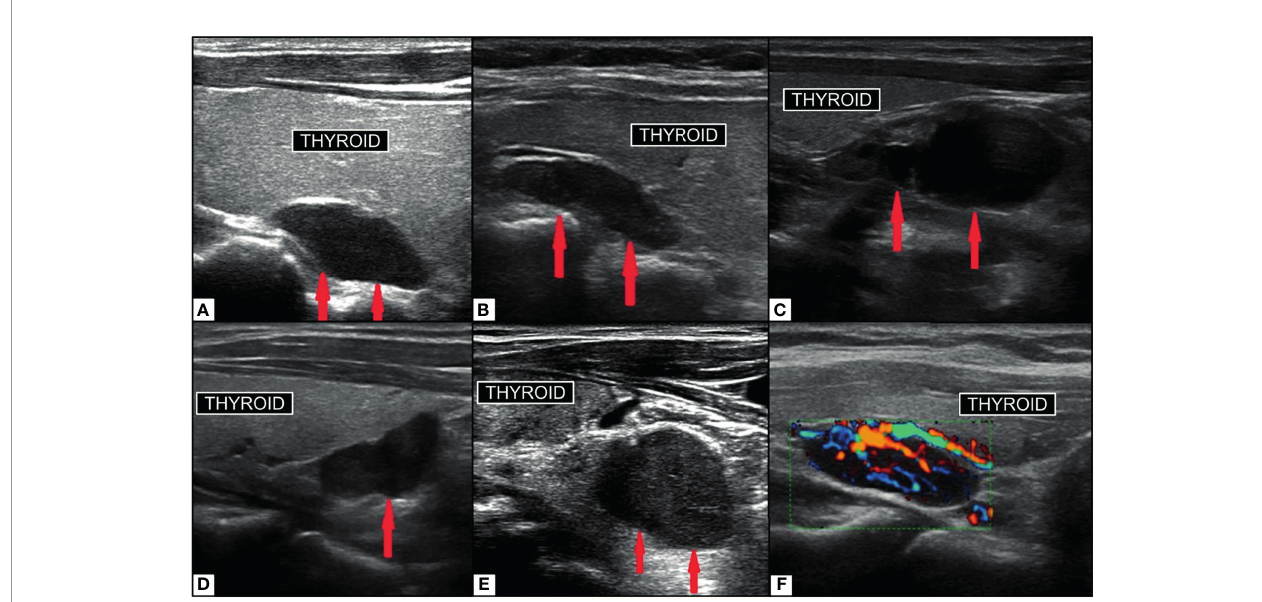
FIGURE 7 | Ultrasound imaging of parathyroid adenoma (red arrows). Right superior PA (A) in median retrothyroidal location, hypoechoic, measuring 2.2cm. Left superior PA (B) in the upper retrothyroidal location, hypoechoic, measuring 2.3 cm. Predominantly cystic right inferior parathyroid adenoma (C) adjacent to lower pole of thyroid, anechoic, measuring 3.5 cm. Right inferior PA (D) in the lower retrothyroidal location, hypoechoic, measuring 2 cm. Left inferior PA (E) near the lower pole of thyroid extending to the retrosternal region, hypoechoic, measuring 2.3 cm. PA on color-doppler ultrasonography (F) with central hyperemia and afferent ‘ polar ’ vessel. Reproduced with permission from: Vitetta GM, Ravera A, Mensa G, Fuso L, Neri P, Carriero A, Cirillo S. Actual role of color-doppler high-resolution neck ultrasonography in primary hyperparathyroidism: a clinical review and an observational study with a comparison of 99mTc-sestamibi parathyroid scintigraphy. J Ultrasound. 2019 Sep;22(3):291-308. doi: 10.1007/s40477-018-0332-3. Epub 2018 Oct 24. PMID: 30357759; PMCID: PMC6704209